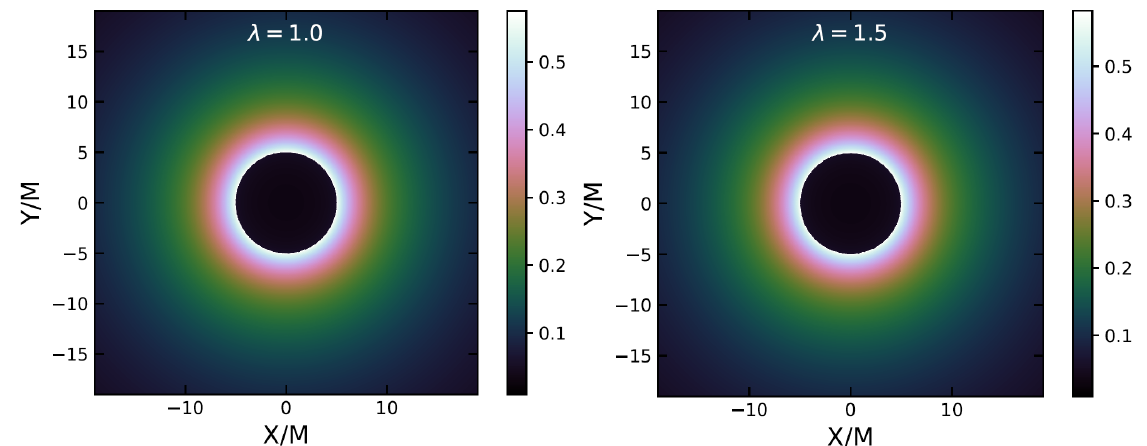
Figure 9. Black hole shadow images and the intensities of the 4D SCBH using an infalling gas and radiation model using different values of λ . We set the black hole mass to M =